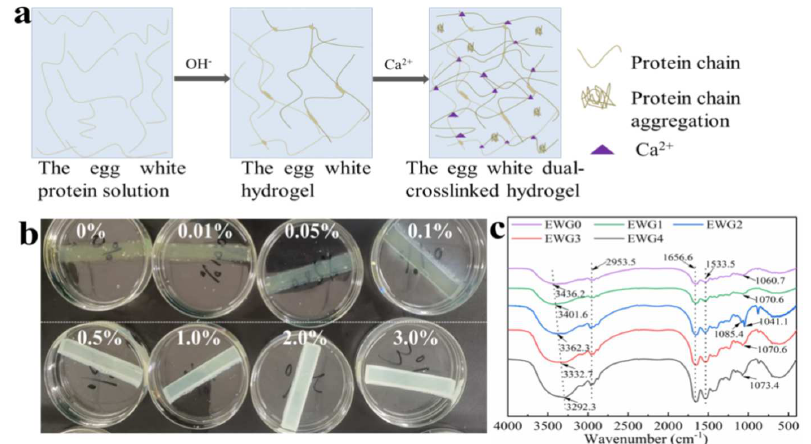
Figure 1. ( a ) Schematic of the EWG hydrogel preparation process; ( b ) photos of the hydrogel immersed in different concentrations of CaCl 2 solution. The number represents the concentration of CaCl 2 solution; ( c ) FT−IR spectra of the hydrogels.